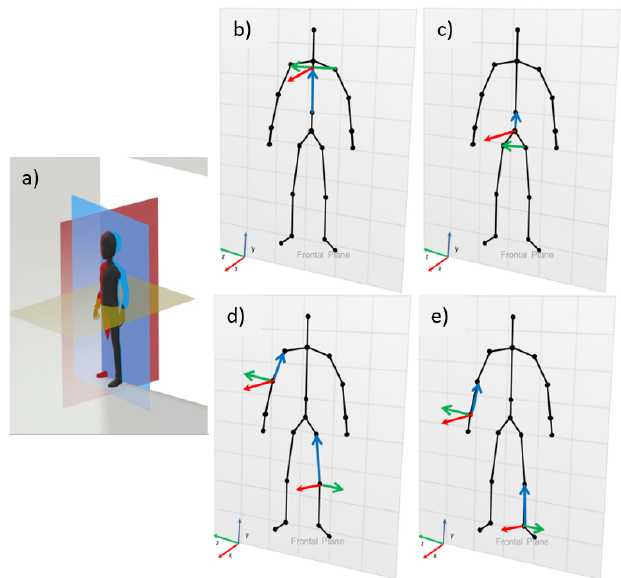
Figure 5. Representations of ISB definitions. ( a ) Anatomical planes. References used for the coordinate system: ( b ) shoulder and cervical; ( c ) pelvis and lumbar; ( d ) elbow and knee; ( e ) wrist and ankle. Adapted from